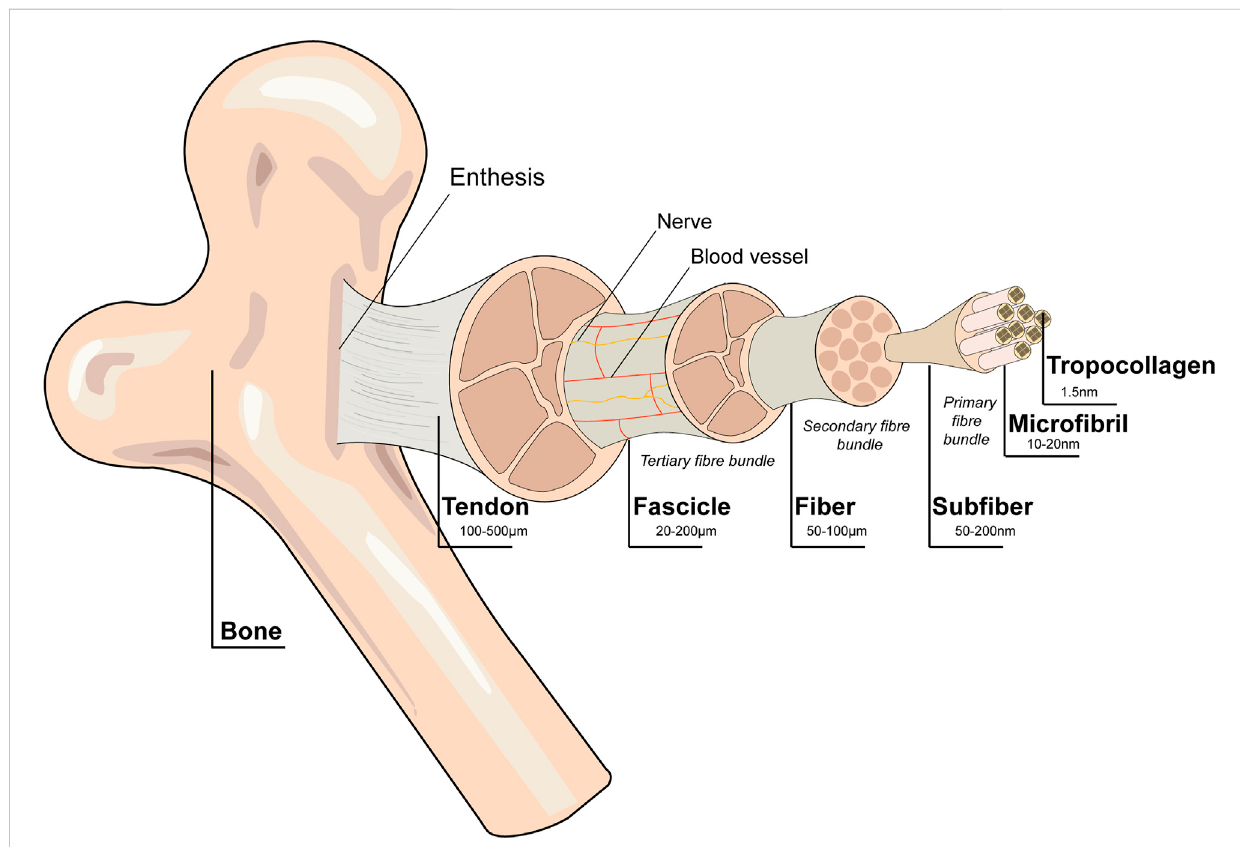
FIGURE 2 Schematicdiagram ofthe tendon hierarchical structure. Collagen alignmentis based on organization into fascicles, fi bers, and fi brils. Tenocytesare the main cellular component of tendons. Blood vessels and nerves are present within the structure. Reproduced with permission (Ruiz-Alonso et al., 2021).